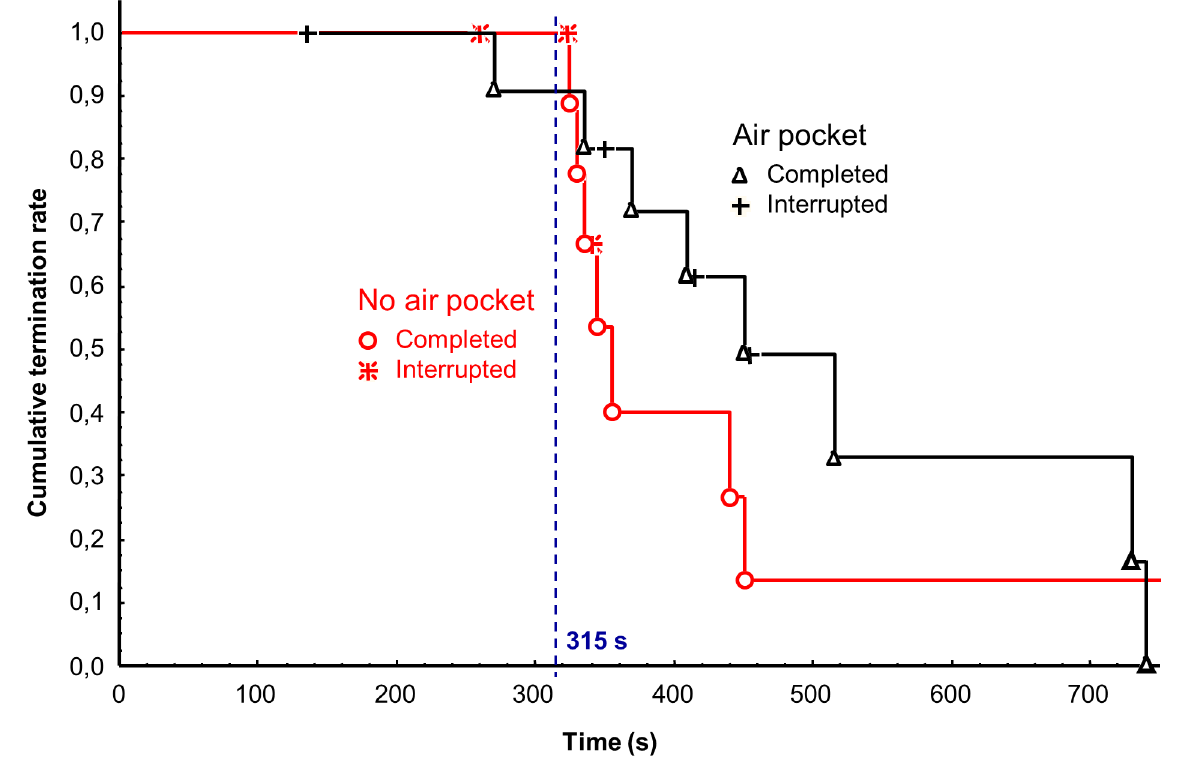
Fig 3. Time to breathing experiment termination for two different conditions: (1) one liter air pocket and (2) no air pocket. The term “ completed ” means that the subject terminated the experiment upon his own request. The term “ interrupted ” means that the experiment was interrupted due to other reasons, e.g. the order by the anesthesiologist, critical physiological parameters determined by the life function monitor, or any technical problem.